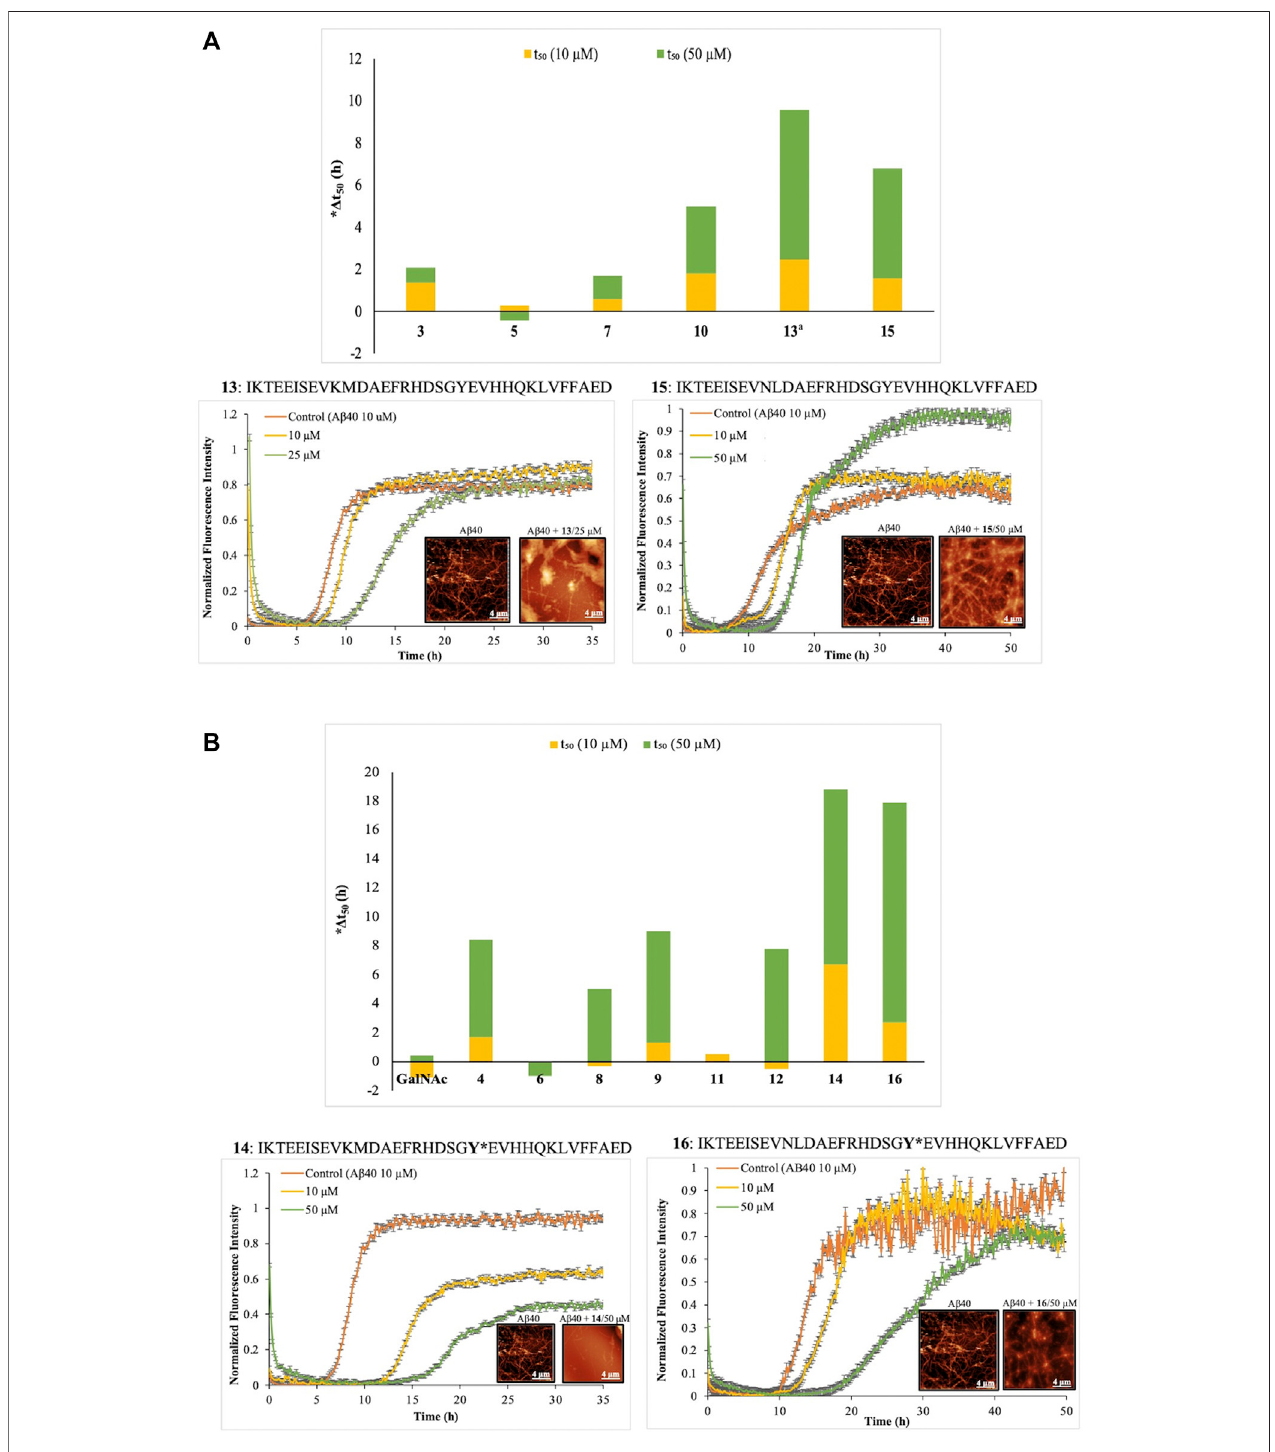
FIGURE2| EffectofAPPpeptides 3,5,7,10,13 ,and 15(A) andglycopeptides 4,6,8,9,11,12,14,16(B) ontheaggregationkineticsofA β 40(10 µM)usingThT fl uorescence assay in phosphate buffer (50 mM, pH 7.4) at 37 ° C. The concentration of (glyco)peptides was 10 and 50 µM a Peptide 13 was run at 10 and 25 µM *Aggregation half-time ( Δ t 50 ) = APP (glyco)peptide t 50 — A β 40 t 50 . The t 50 values are means of triplicate kinetics results. Alongside are tapping mode atomic force microscopy images of A β 40 fi bril growth upon 24 h incubation with nonglycosylated peptides, 13 and 15 (A) and Tyr- O -glycopeptides, 14 and 16 (B) .